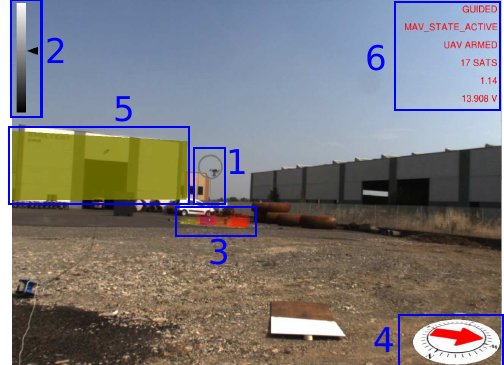
Figure 8. Augmented reality scene example with graphical overlays highlighted by blue boxes (for better